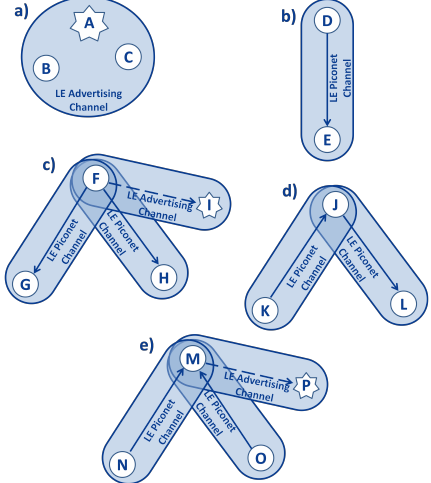
Figure 12. Example of BLE topology [59]. In the figure, solid arrows point from master to slave ; dashed arrows indicate a connection initiation and point from initiator to responder . Each device is represented with a capital letter; devices that are connected are represented with a circle, while devices that are advertising are indicated using stars. Group ( a ) in Figure 12 is a simple broadcasting topology, where A is an advertiser , while B and C are scanners , which are using a BLE advertising physical channel. Group ( b ) is a basic piconet , with only one physical channel, where D acts as master and E as slave . In group ( c ), the master is F, and it is using two piconet physical channels with slaves G and H. Device F is also the initiator of the connection with device I, which is advertising with connectable advertising packets on the advertising physical channel; device F can start the connection and add slave I to its piconet . A network topology like this one, with only one master and several slaves , is called a star network. In scatternet ( d ), device J is using one LE physical channel with K and one with L. J is the master in the piconet with L and the slave in the one with K. In scatternet ( e ), device M is the slave of two physical channels, whose masters are N and O. Device P is advertising using a connectable advertising event on the advertising physical channel, and the device M is the initiator ; when the connection is formed, M will result in being the master of this